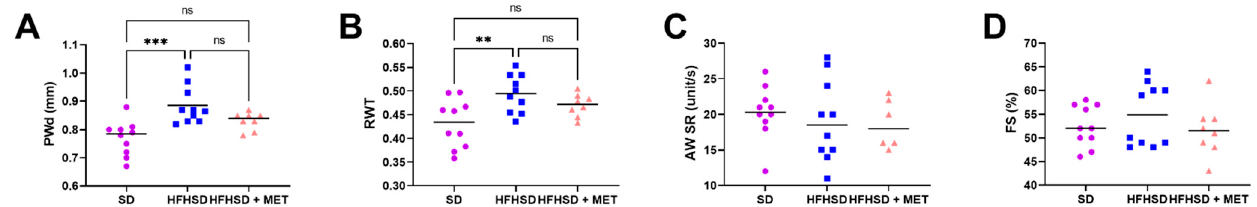
Figure 3. Determination of the metformin effect on cardiac function after 16 weeks of HFHSD by echocardiography. ( A ) Quantification of the posterior wall thickness in diastole (PWd). ( B ) Calculation of the relative wall thickness (RWT = 2 × PWd/LVEDD) as an index of concentric hypertrophy (RWT > 0.42). Quantification of the anterior wall strain rate, AW SR, in ( C ) and of the fractional shortening, FS, in ( D ); n = 8 to 10 mice/group. Mean, one-way ANOVA with Tukey’s multiple comparisons test. ** p < 0.005, *** p < 0.001. ns = non-significant. Symbols: circle: SD, square: HFHSD, triangle: HFHSD + MET.